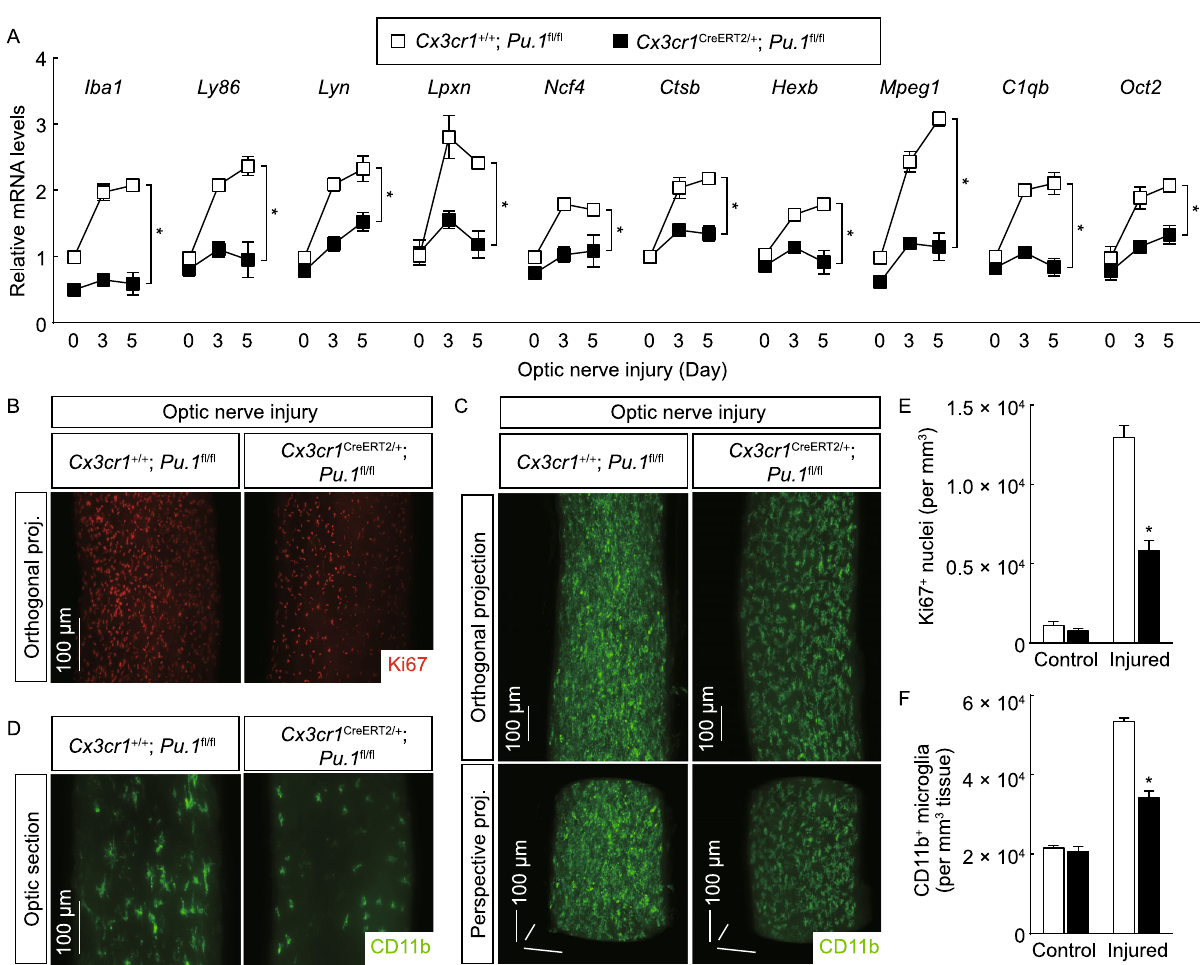
Figure 7. Post-developmental PU.1 is essential for microglial activation. Cx3cr1 +/+ ; Pu.1 fl / fl vs. Cx3cr1 CreERT2 /+ ; Pu.1 fl / fl mice were treated with 4-hydroxytamoxifen to induce the Cre-recombinase activity and then subjected to optic nerve